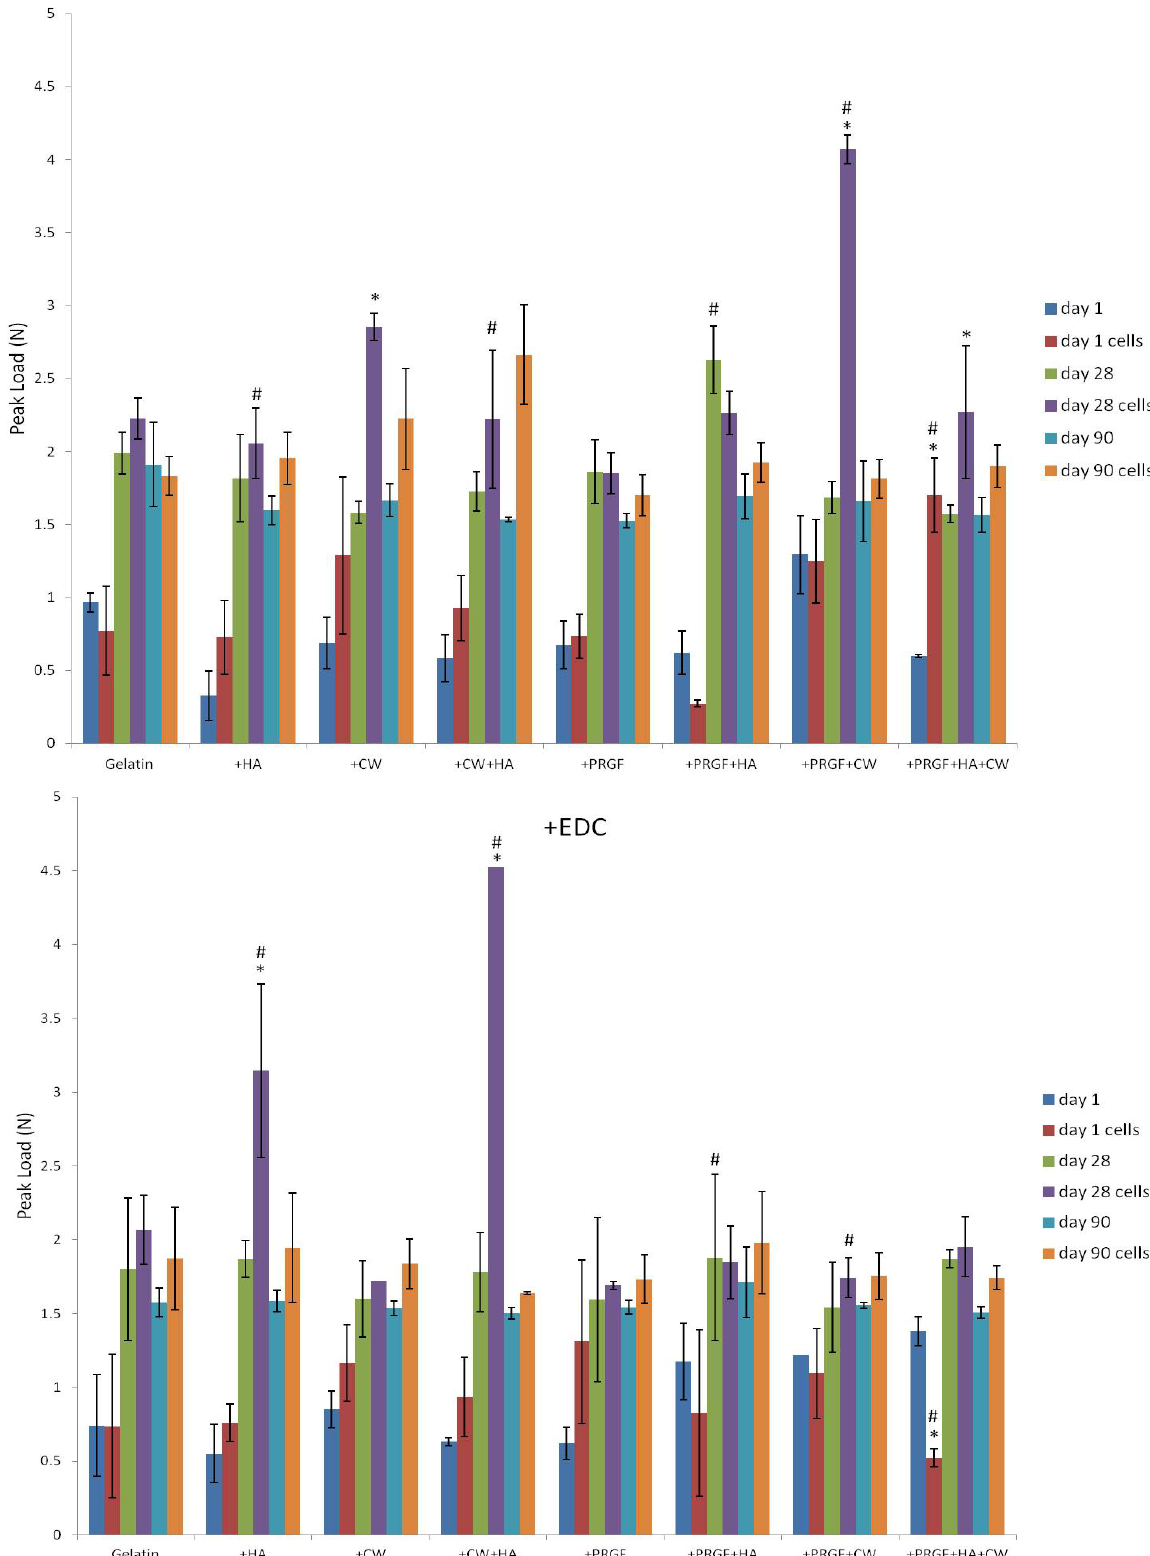
Figure 9. Peak load (N) of acellular and cellular scaffolds over 90 days incubation. * denotes a statistical difference ( p < 0.05) between cells and no cells for a specific day and scaffold composition. # denotes a statistical difference ( p < 0.05) when comparing cross-linking methods of each